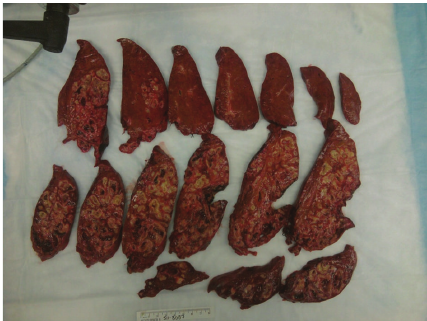
Figure 3: A cut surface of the liver with tan white nodules of varying size. The lesions are characterized by liquefactive necrosis with degenerating and necrotic liver